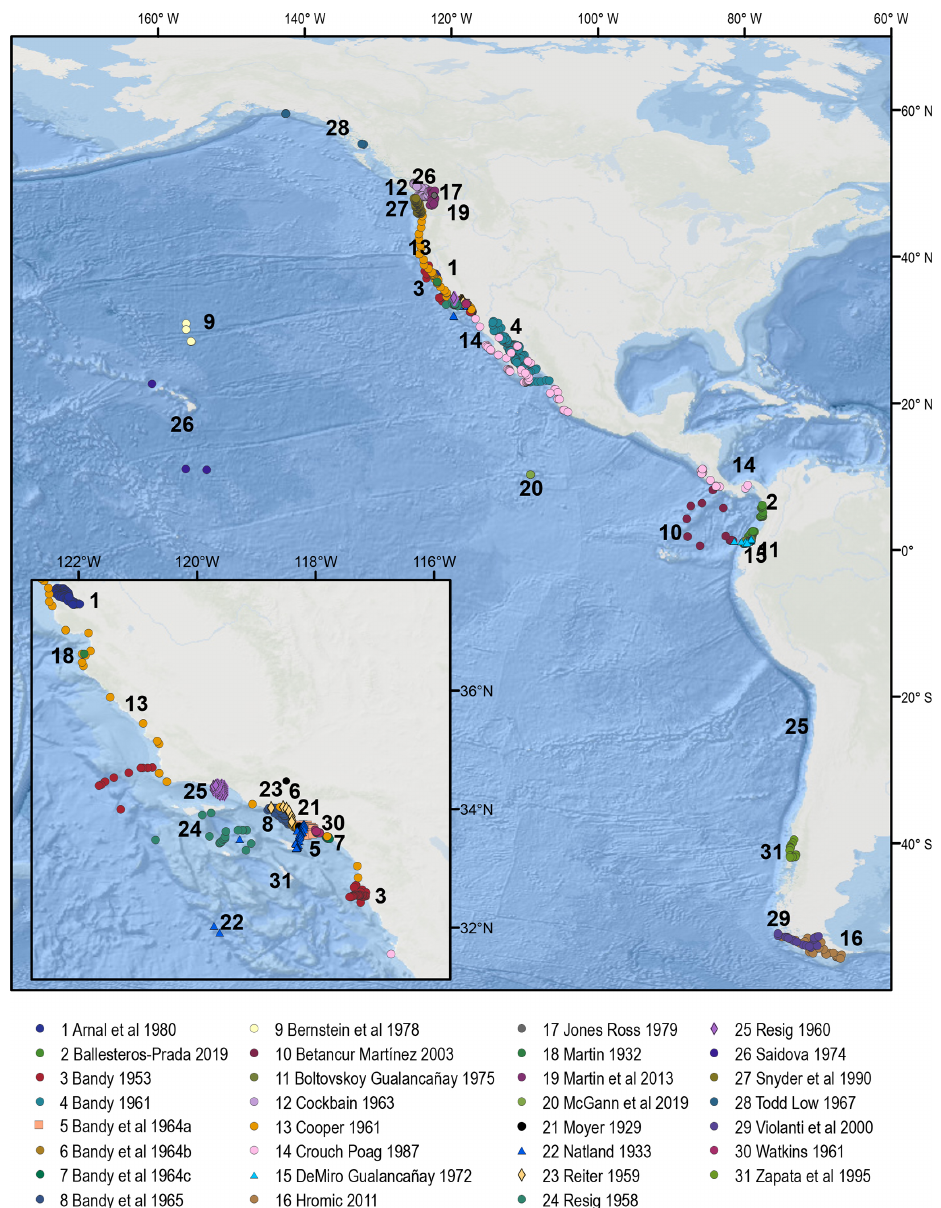
Figure B1. Spatial distribution of samples in the eastern Pacific from studies that do not provide quantitative assemblage data. The numbers refer to each author’s dataset. The sample geolocation and metadata can be found at https://doi.org/10.1594/PANGAEA.947114 (Diz et al., 2022b). The procedures for stations’ georeferencing and column coding are outlined in Sect. 2.3 and 2.5 respectively. The map was made using ArcGIS software version 10.8.2. The global relief model integrates land topography and ocean bathymetry using information from Esri, Garmin, GEBCO, NOAA NGDC, and other